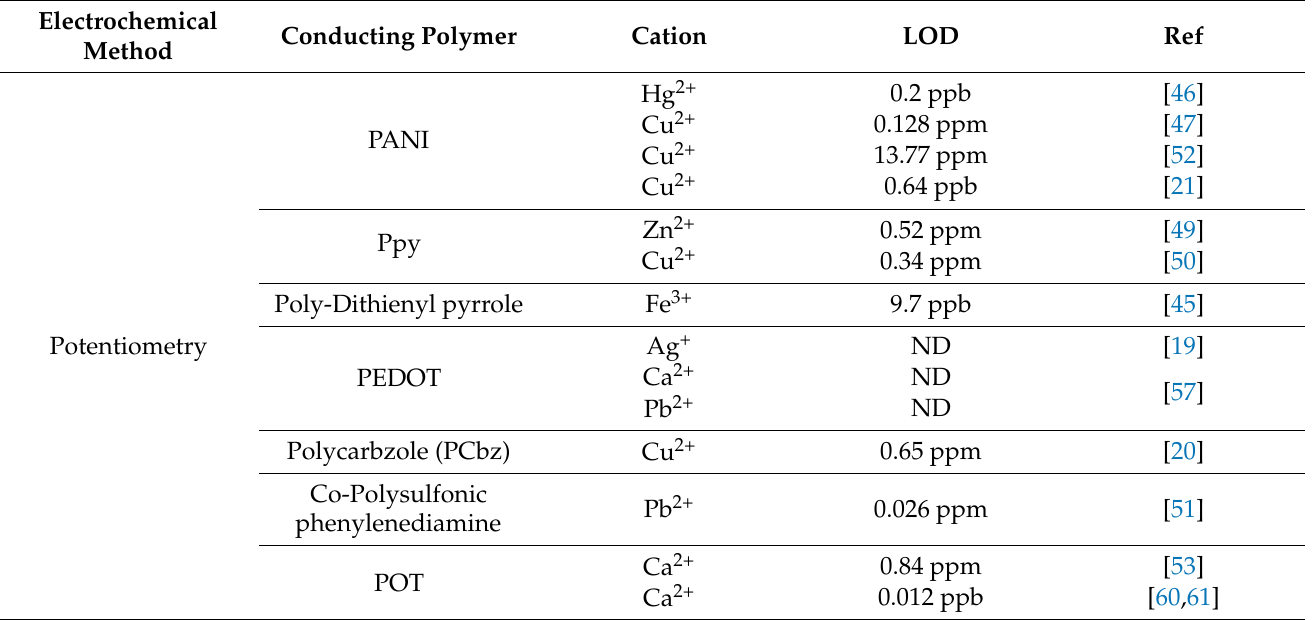
Table 1. Metallic cations analyzed using conducting polymers modified electrodes. Electrochemical